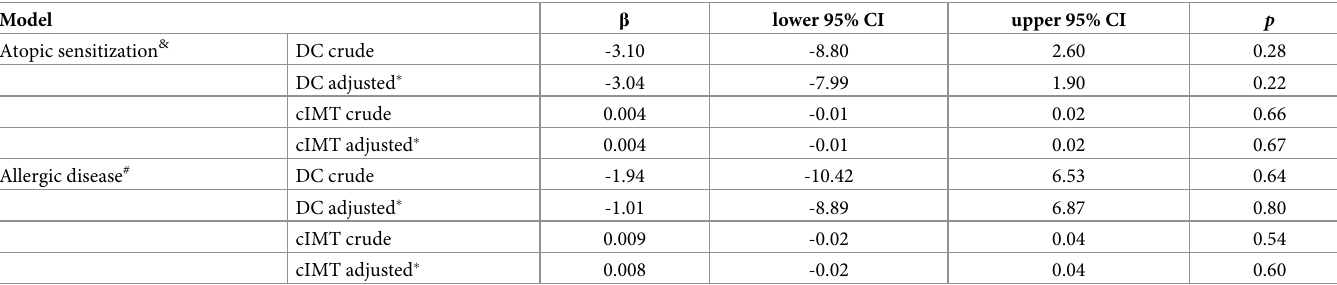
Table 2. Multiple linear regression analysis of associations of atopic sensitization and allergic disease with DC and cIMT.